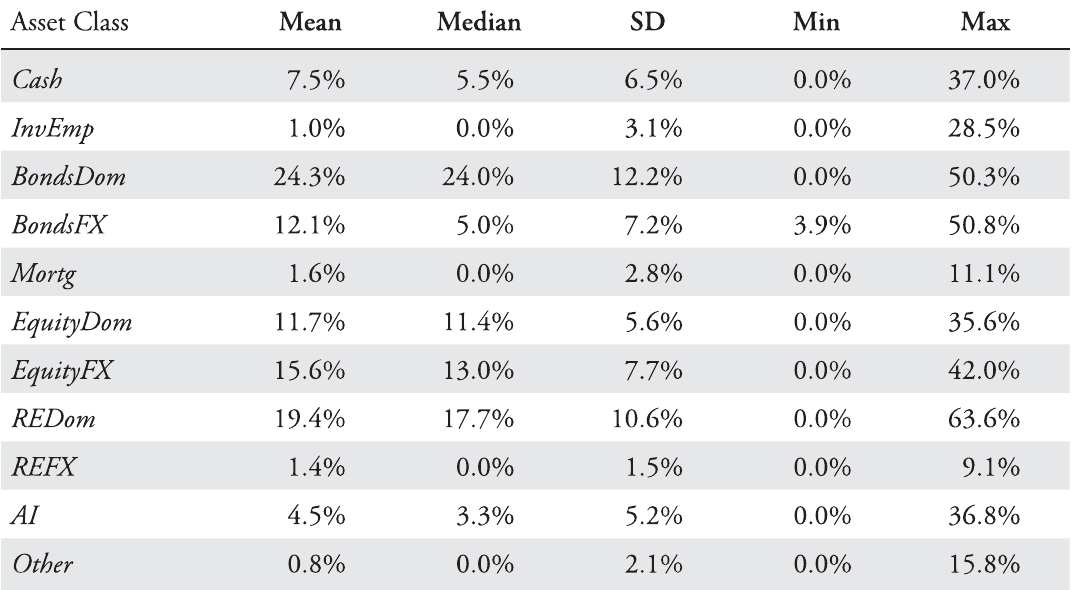
Table 17: Descriptive Statistics of Realised Asset Allocation